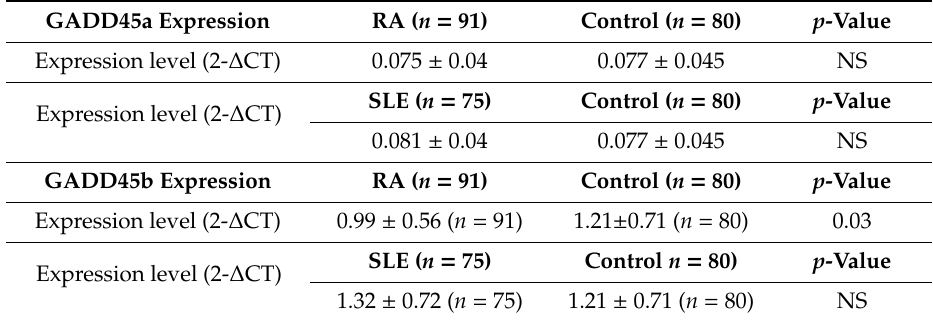
Table 1. The RNA expression of GADD45a and GADD45b in rheumatoid arthritis (RA) and systemic lupus erythematosus (SLE) patients.